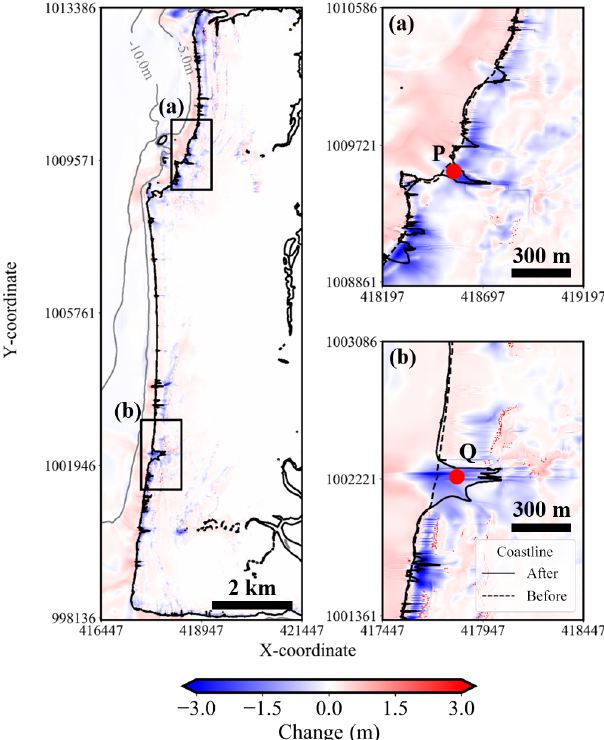
Figure 5. Topographic change and shoreline position caused by the tsunami (solid and dashed lines show the coastline after and before the tsunami in the simulation; P and Q are the points of confirmed local beach erosion in regions (a) and (b); blue and red map erosion and deposition after the tsunami in the